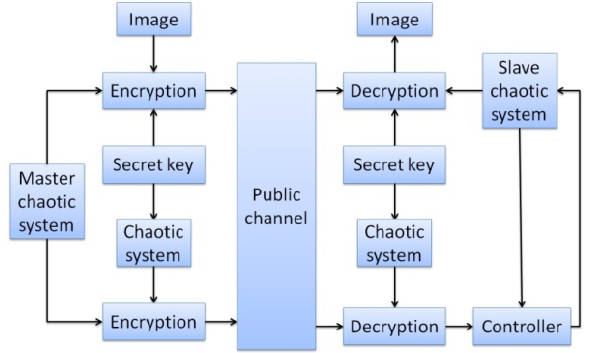
Figure 3. Structure diagram of Image encryption and decryption of chaotic synchronous cryptographic system.